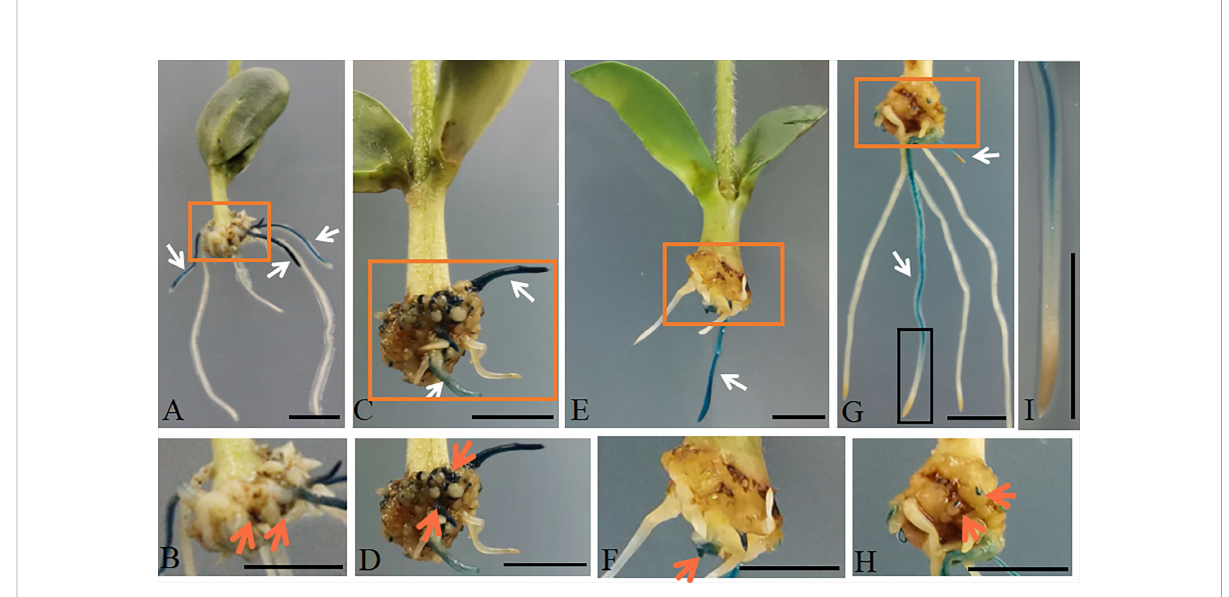
FIGURE 3 AtGCSpro activity assay with different shortened lengths in soybean hairy roots by ARM transformation. AtGCSpro 1977 :: GUSPlus (A, B) . AtGCSpro 1629 :: GUSPlus (C, D) . AtGCSpro 1178 :: GUSPlus (E, F) . AtGCSpro 833 :: GUSPlus in the soybean hairy roots (G, H) . The transgenic root marked in the black box in picture (G) is closed-up (I) . White arrows indicate the transgenic roots. Pictures B, D, F, and H are closed-up of sections (A, C, E), and G marked in the orange boxes, respectively. The GUS signal was found in the teratoma where hairy roots can initiate (indicated by orange arrows). All composite plants were observed from 16-day-old post-infected seedlings. Bars = 1